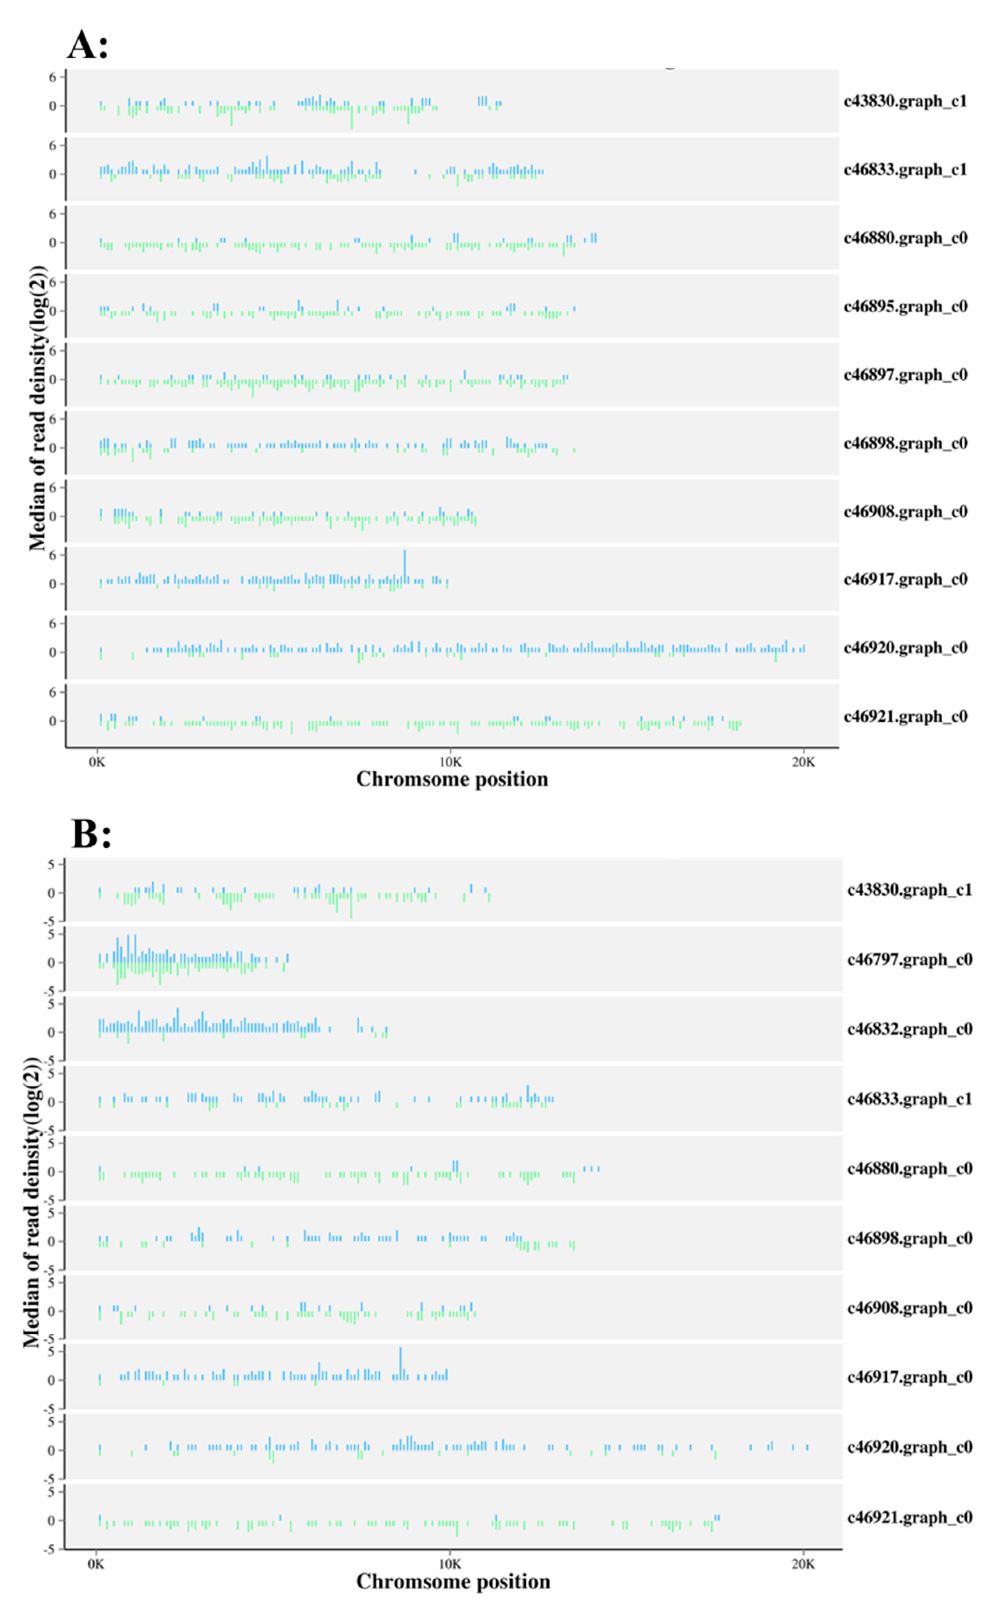
Figure 2. Genome-wide distribution of read coverage on each chromosome. X-axis: location of reads at each chromosome; Y-axis, the coverage intensity in Log2 value. ( A ) Eggs ( B ) J2 Juveniles.